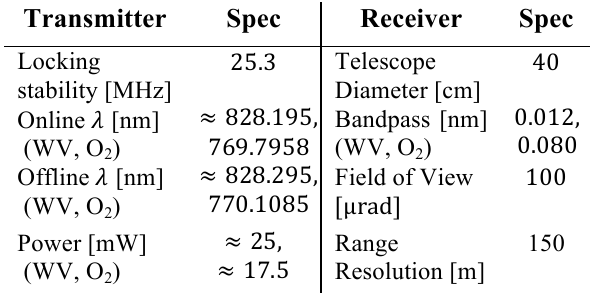
Table 1: Transmitter and Receiver specifications. Transmitter